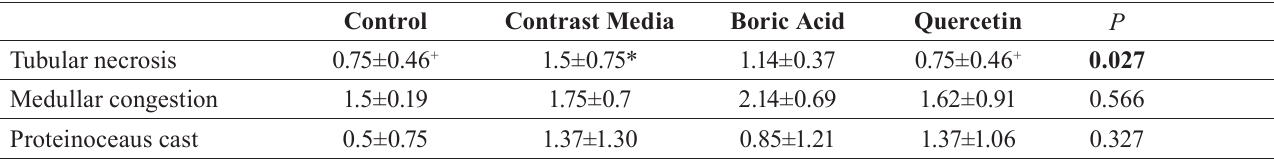
TABLE I - P athology S coring